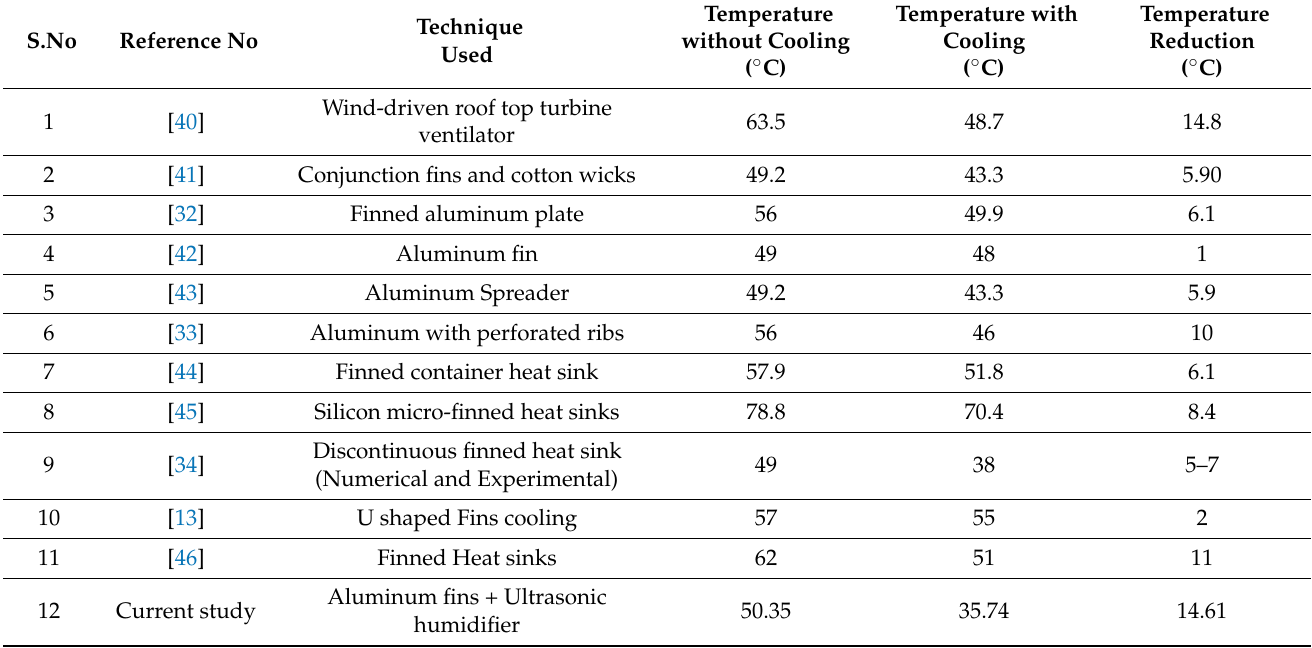
Table 3. Comparison with other published works.